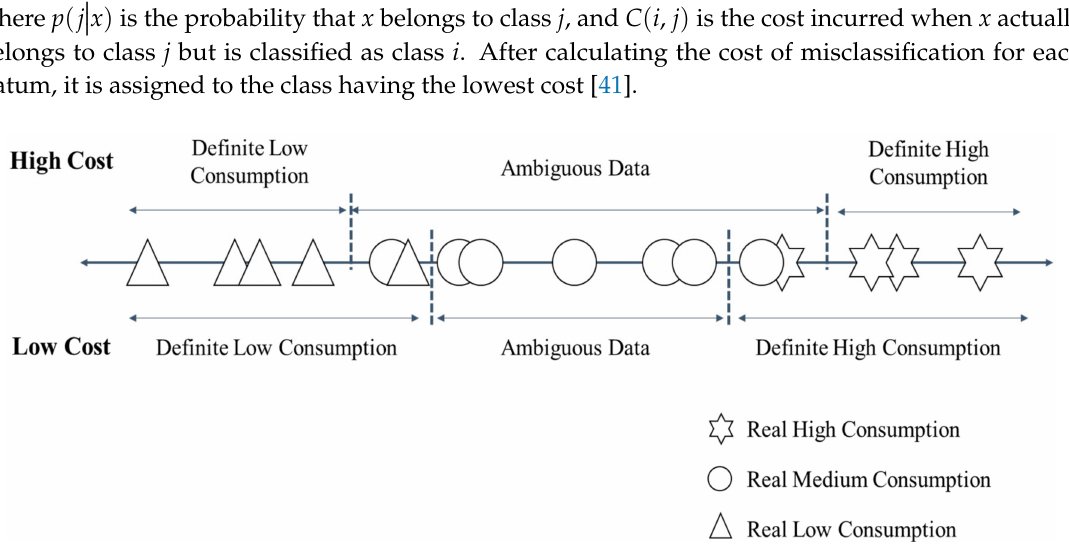
Figure 5. Filtering results according to